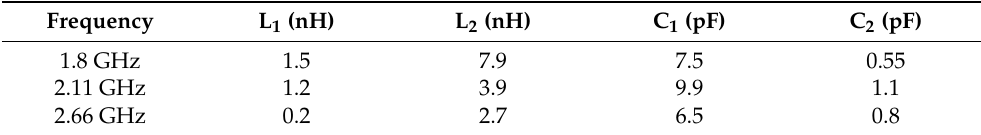
Table 4. Electrical ideal element values of the impedance matching circuits for different frequency bands.